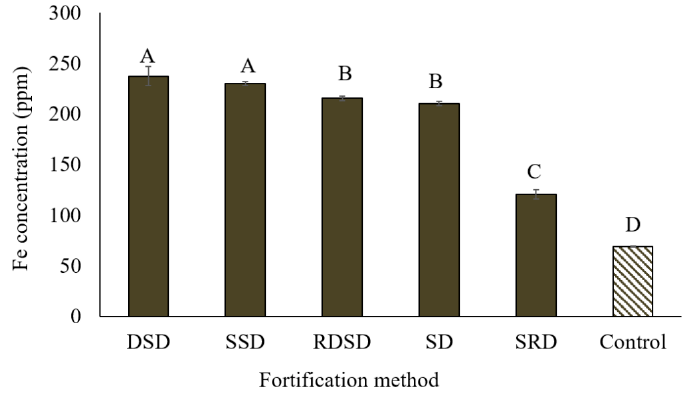
Figure 3. Iron concentration in polished football lentil dal fortified with FeSO 4 ·7H 2 O solution (1600 ppm Fe) at 10 mL/100 g lentil dal using five different techniques. DSD = lentil dal oven dried for 10 minutes followed by soaking in fortificant solution and drying at 80 ◦ C; SSD = lentil dal sprayed with fortificant solution followed by shaking and drying; RDSD = lentil dal rinsed, oven dried, followed by soaking in fortificant solution and then drying; SD = lentil dal directly soaked in fortificant solution followed by drying; SRD = lentil dal soaked in fortificant solution followed by rinsing with deionized water and drying. Different letters within the figure represent significant differences ( p <